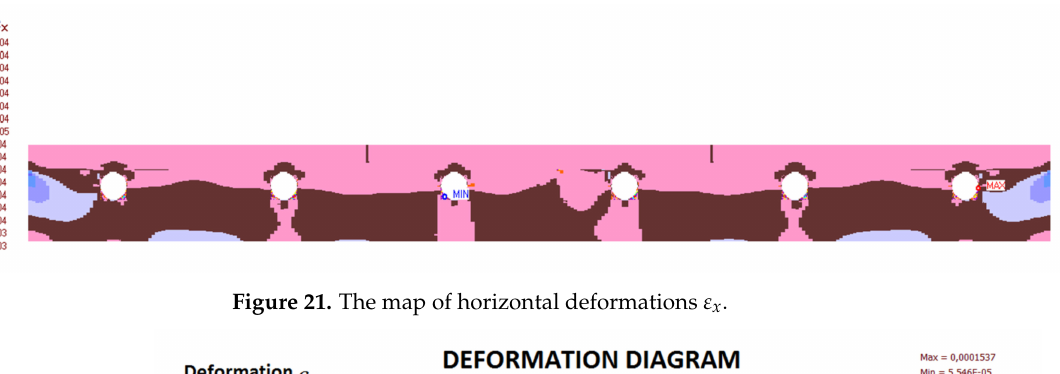
Figure 20. The map of horizontal stresses σ x and cross-section location.